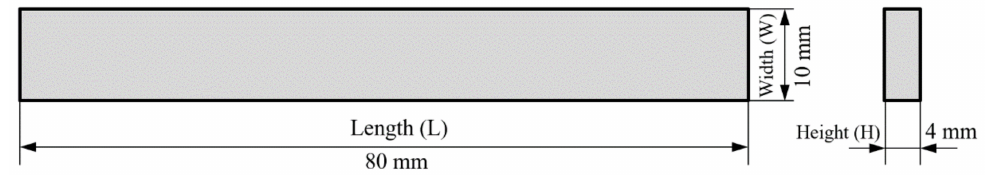
Figure 1. ISO 179-1:2010 Type 1 geometry. ABS samples were manufactured using an Ultimaker 3 Extended printer (Ultimaker B.V., Gerdelmalsen, The Netherlands) equipped with a 0.4 mm-diameter nozzle. All building lines of each specimen have been printed without differences between infill lines, wall lines and bottom and top layer lines. A unidirectional raster orientation with a 100% density infill line pattern was chosen. In the fabrication process, the following values were used: printing speed of 60 mm/s, temperature of 240 ◦ C and build plate temperature of 80 ◦ C. In order to reduce the interaction between lines of the same layer, a layer height of 0.2 mm and a line width of 0.5 mm were chosen (Figure